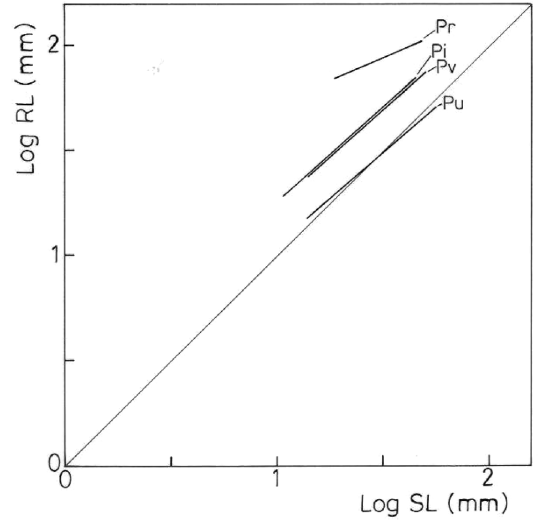
Fig. 5. Plots of the logarithm of radula length against the loga- rithm of shell length (Pi = P. intermedia , Pr = P. rustica , Pu = P. ulyssiponensis , Pv = P.